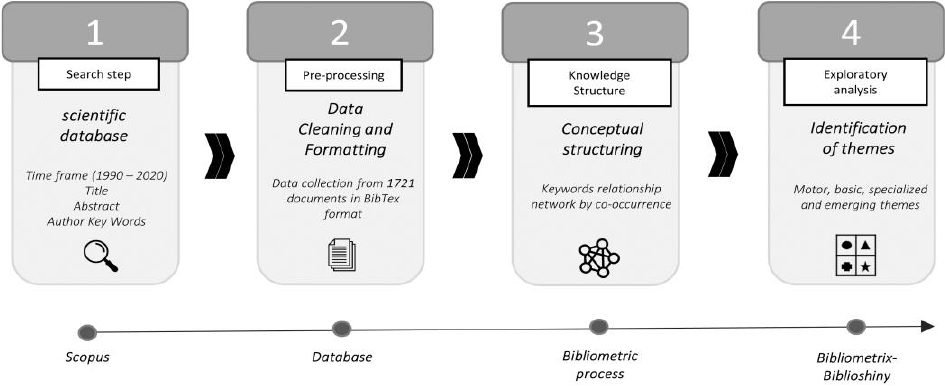
Figure 1. Methodological steps.